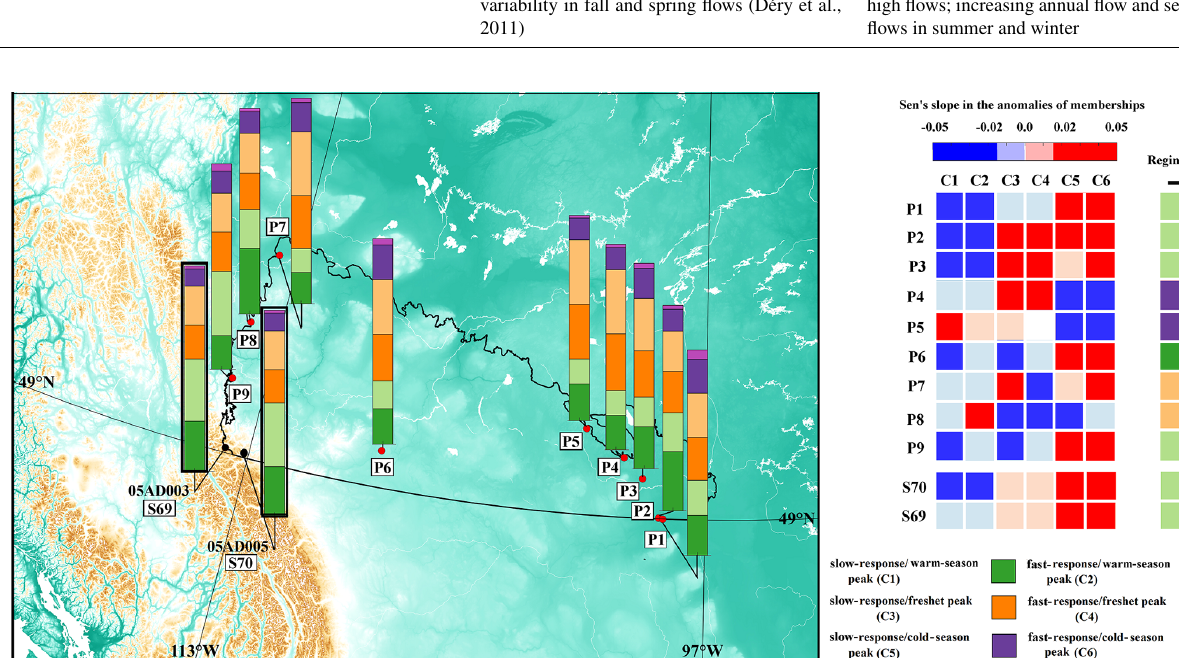
Figure 12. Validation of the proposed algorithm in nine out-of-sample streams during 1976 to 2010 in the Canadian Prairies. The colour bars in the left map show the degrees of membership to each cluster. The right panel shows the trends in the degree of membership in the six clusters at the 11 stations considered. Positive and negative trends are shown with red and blue colours, respectively. Sharp colours show significant cases. The out-of-sample stations S1 to S9 are sorted from east to west from the top to the